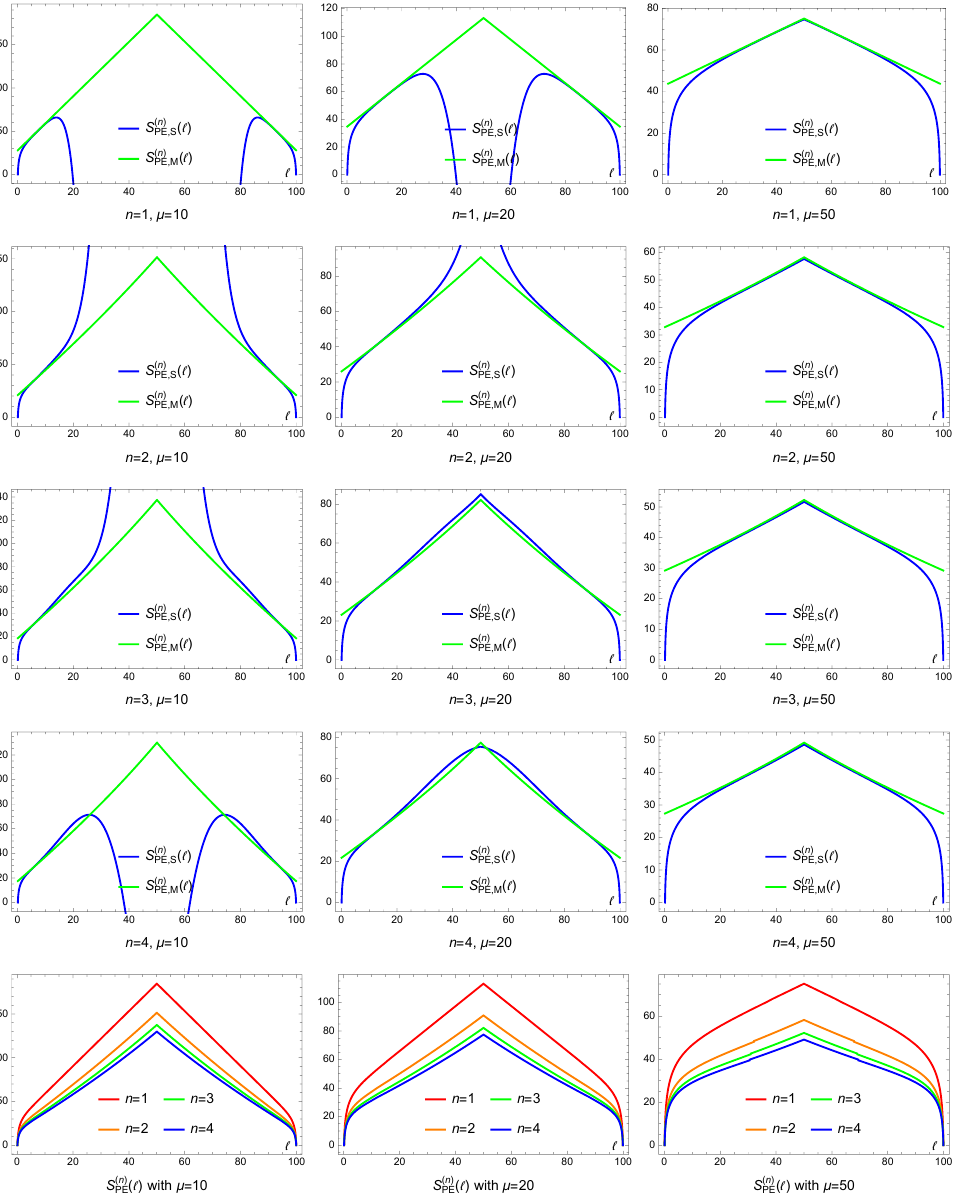
Figure 3 . In the (cid:12)rst four rows, we plot the R(cid:19)enyi entropy of short interval (4.1) and medium interval (4.2), and for the long interval L= 2 < ‘ < L we use S ( n ) we plot the piecewise R(cid:19)enyi entropy (4.3). We remind the reader that the medium interval R(cid:19)enyi entropy for the primary excited state (4.2) is a conjecture. To draw the (cid:12)gures, we have set c = 30, L = 100, and (cid:15) = 0 : 1.